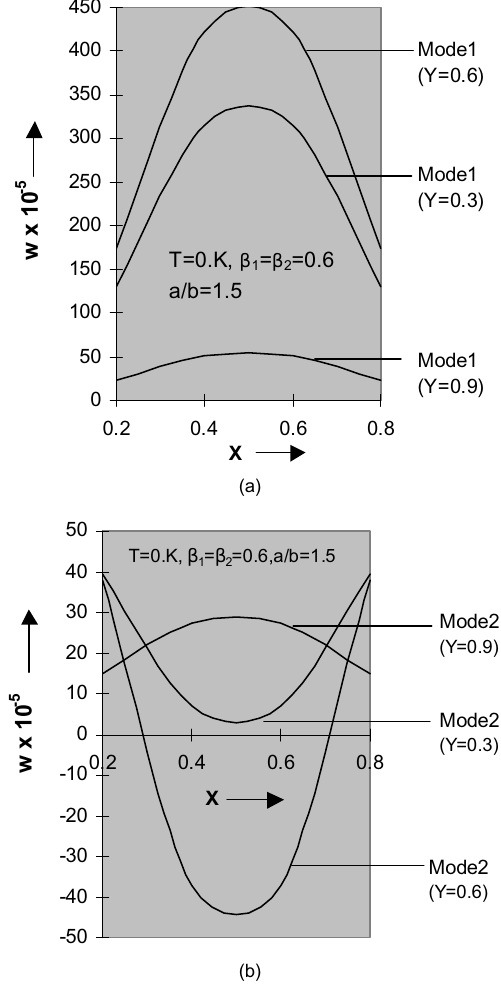
Fig. 6. (a) Deflection w vs X of a clamped visco-elastic rectangular plate (b) Deflection w vs X of a clamped visco-elastic rectangular